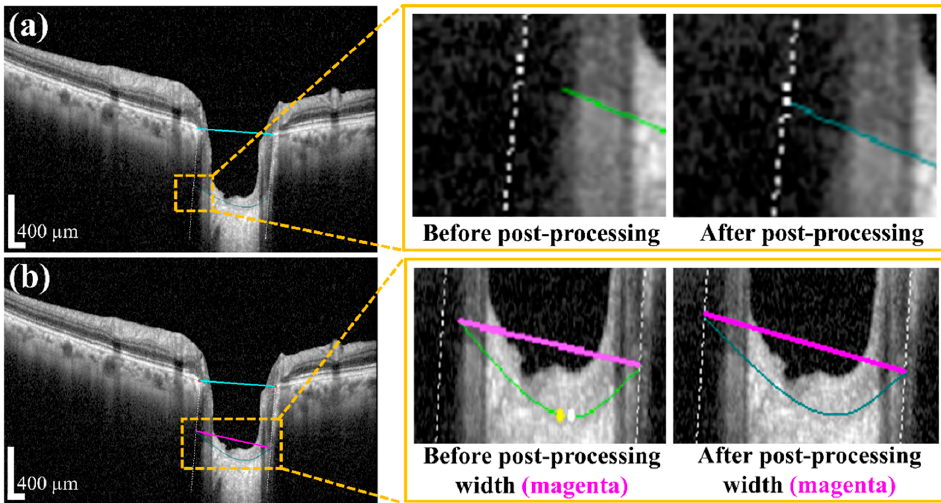
Figure 10. The results of post-processing: ( a ) Post-processing results of anterior LC curve (inside the box indicated the before and after post-processing of the anterior LC curve); ( b ) calculation of post-processing result of the width. Scale bar: 400 µm.